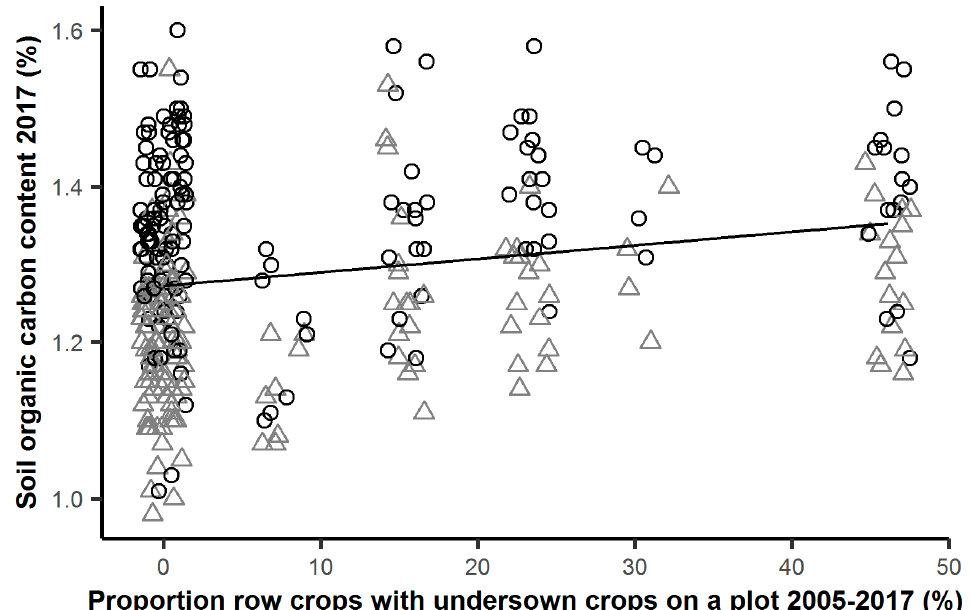
Figure 5. Correlation between the number of years of row crops with undersown crops (white clover in maize in CR5 and CR6, clover-grass in sunflower in CR8) on a plot in the period 2005–2017, and the SOCc (%) of that plot in 2017. Unfertilised plots are represented by grey triangles, fertilised plots by black circles. The regression line is the combined (fertilised and unfertilised) regression line (y = 1.27 + 0.002x, R 2 = 0.04, p < 0.001, n = 316). Jitter was added to the proportion of row crops to improve visibility of symbols.